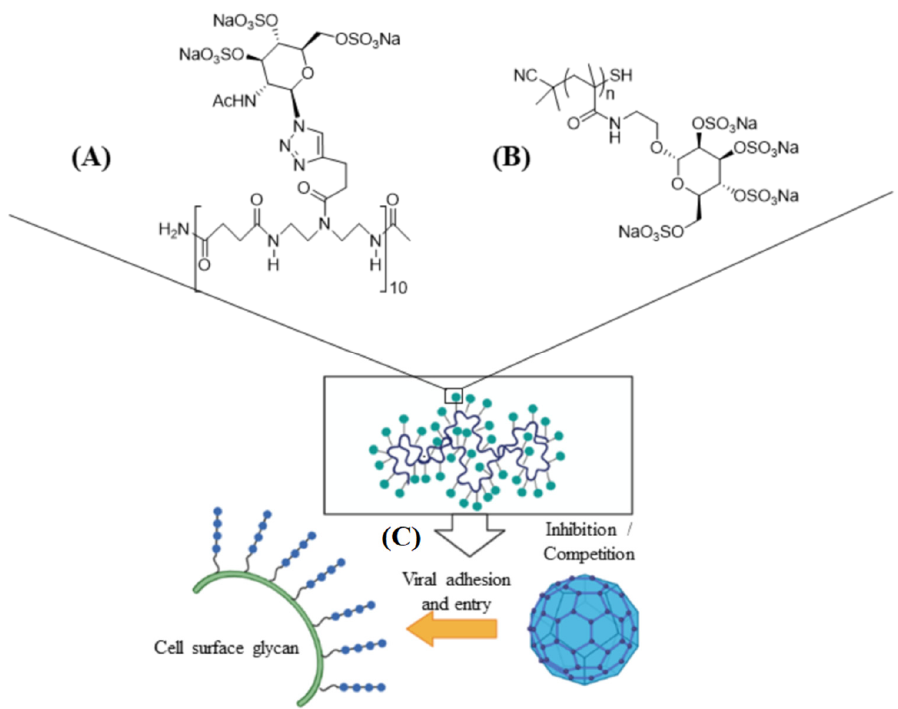
Figure 4. Schematic representation of short (( A ), 10 sugar units) and long (( B ), n units) chain oligomeric sulfated saccharides to mimic different properties of glycopolymers; ( C ) the sulfated glycopolymers block viral infection by interfering with virus attachment to the cell surface. Reprinted with permission from Ref. [23]. Copyright 2020, American Chemical Society.